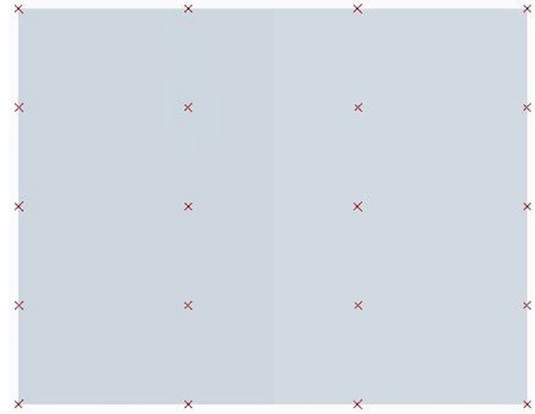
Figure 4. Nodes selected for distortion measurement.